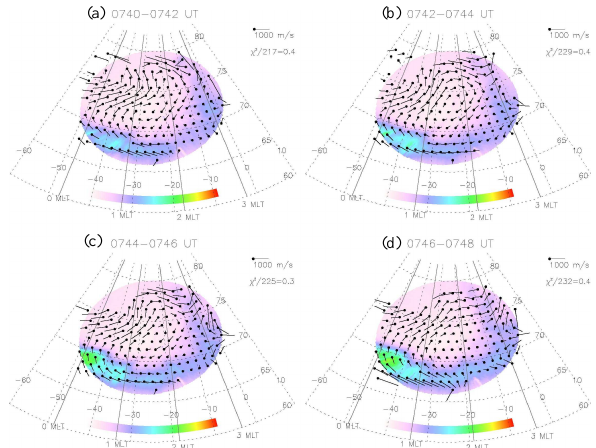
Figure 5 Maps similar to Figure 4, but for the period 0740-0748 UT. Fig. 5. Maps similar to Fig. 4, but for the period 07:40–07:48